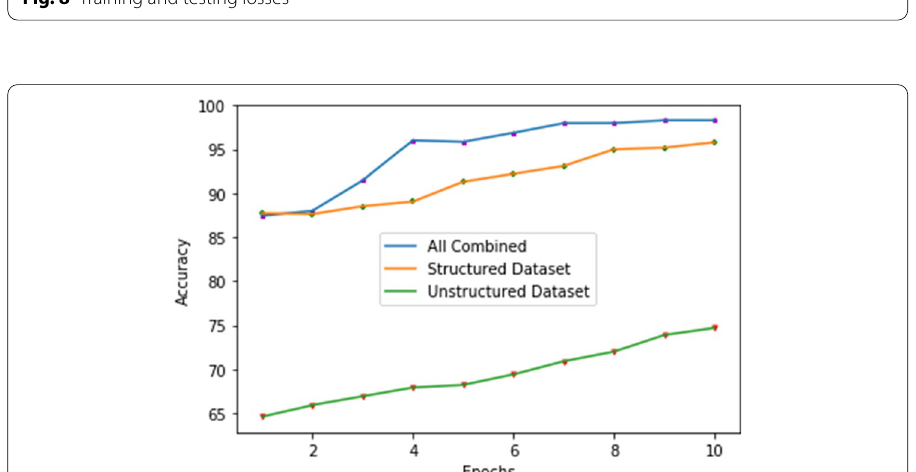
Fig. 9 Accuracy plots of structured, unstructured and combined stock information for stock market